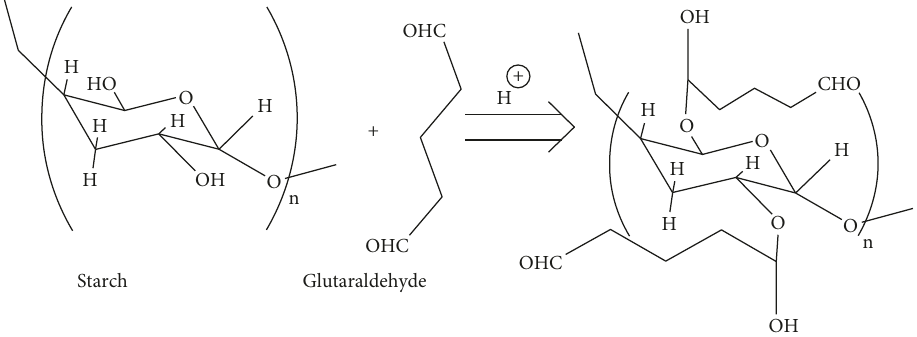
Scheme 2: Modified starch by